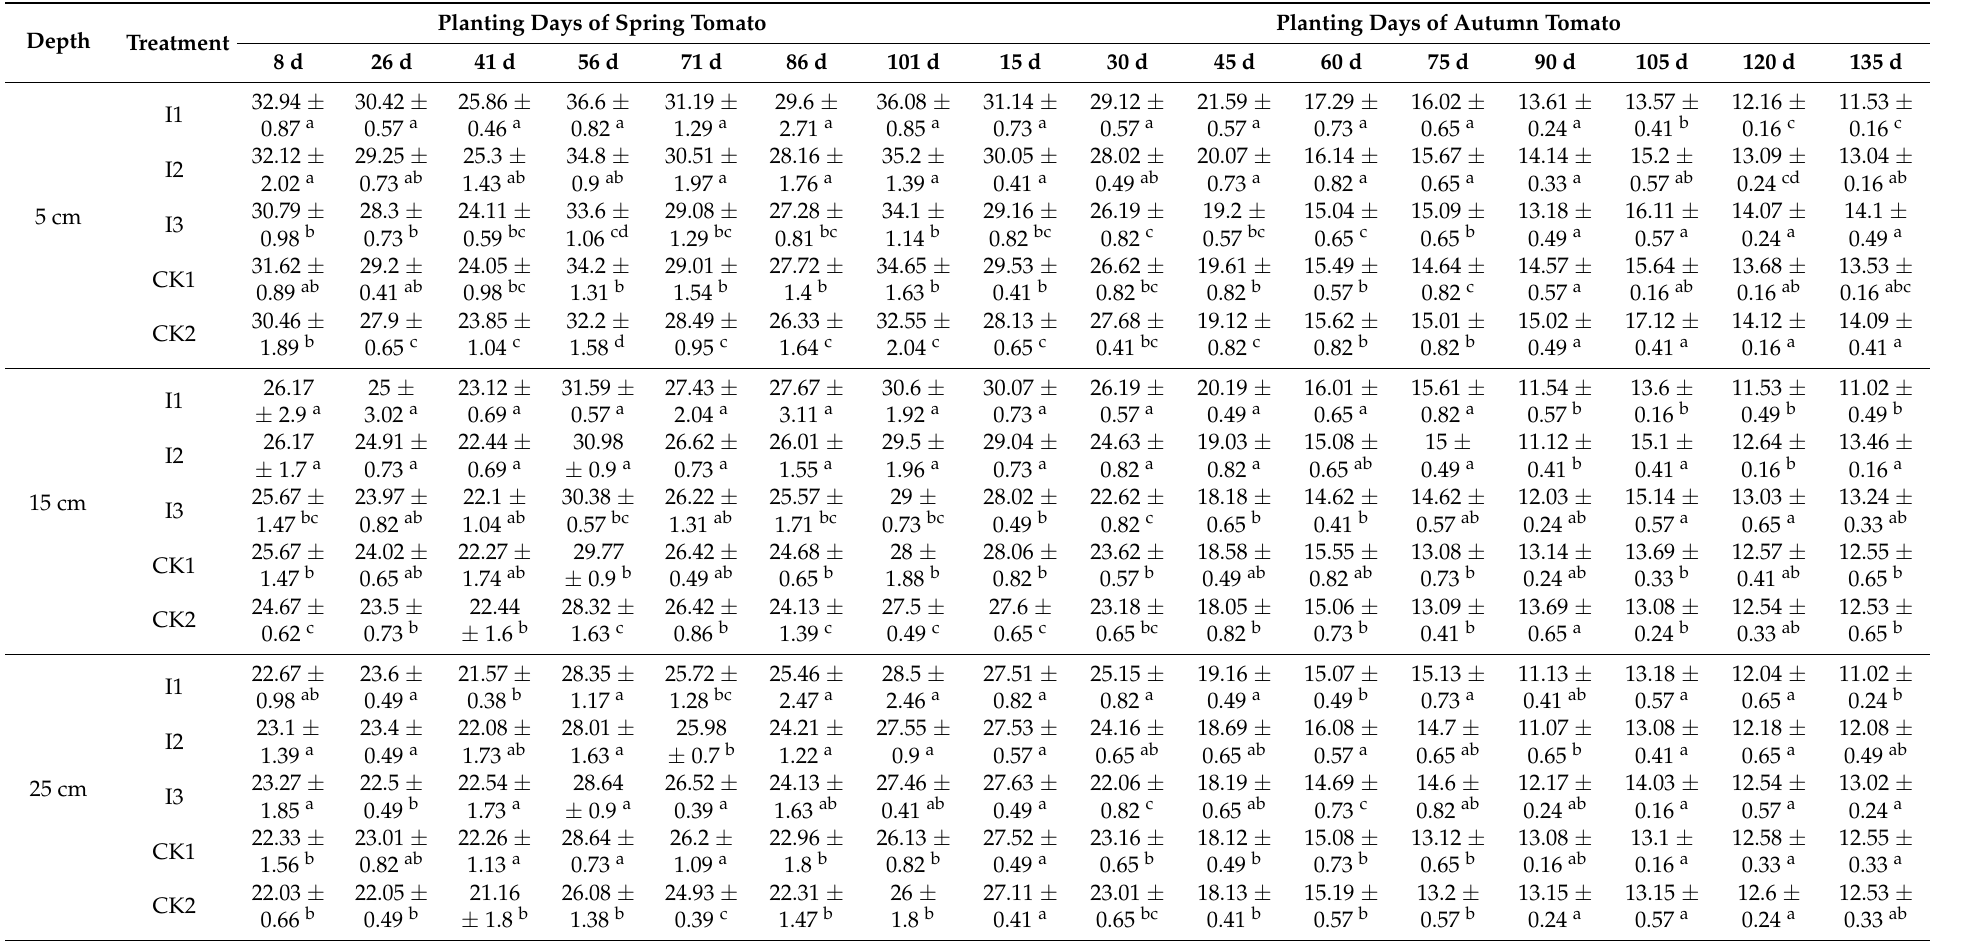
Table 4. Changes of soil temperature with tomato growth period under different treatments ◦